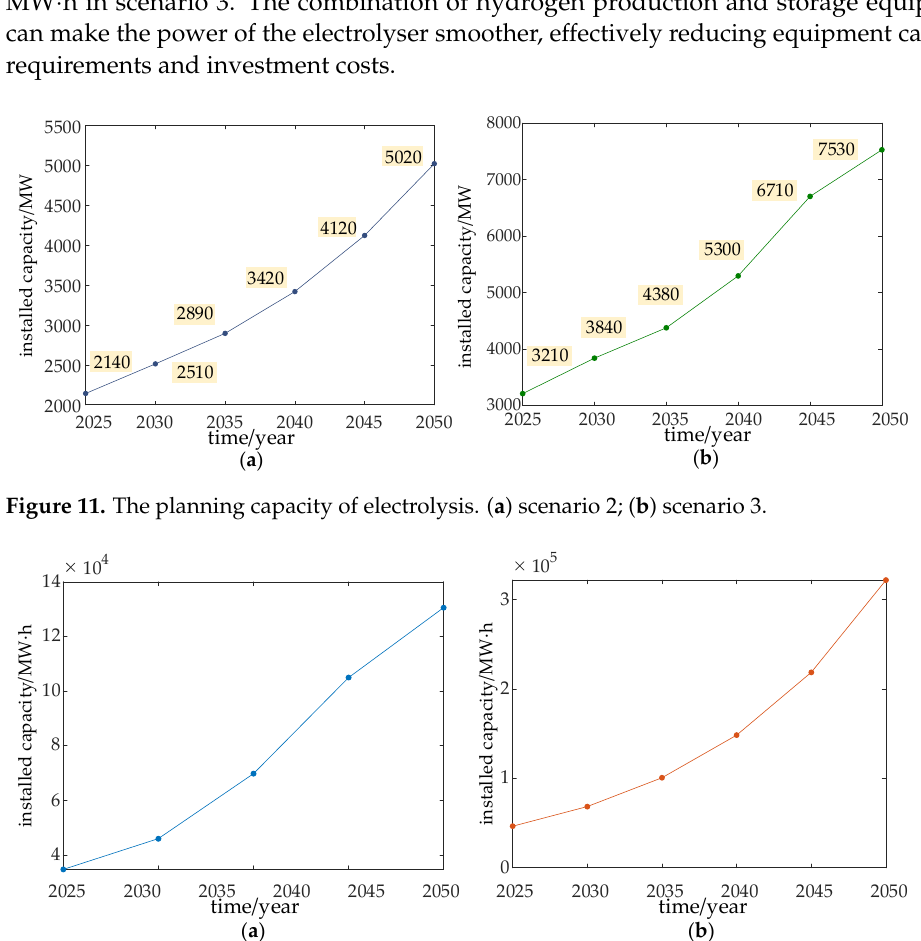
Figure 10. The installed capacity of and share of the power sources. ( a , b ) scenario 1; ( c , d ) scenario 2; ( e , f ) scenario 3.